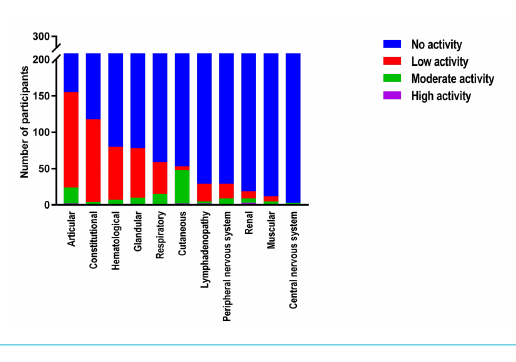
Figure 2: Distribution of domain activity levels in participants with a ClinESSDAI ≥5, n = 288.ClinESSDAI = Clinical EULAR Sjögren's Syndrome Disease Activity Index.